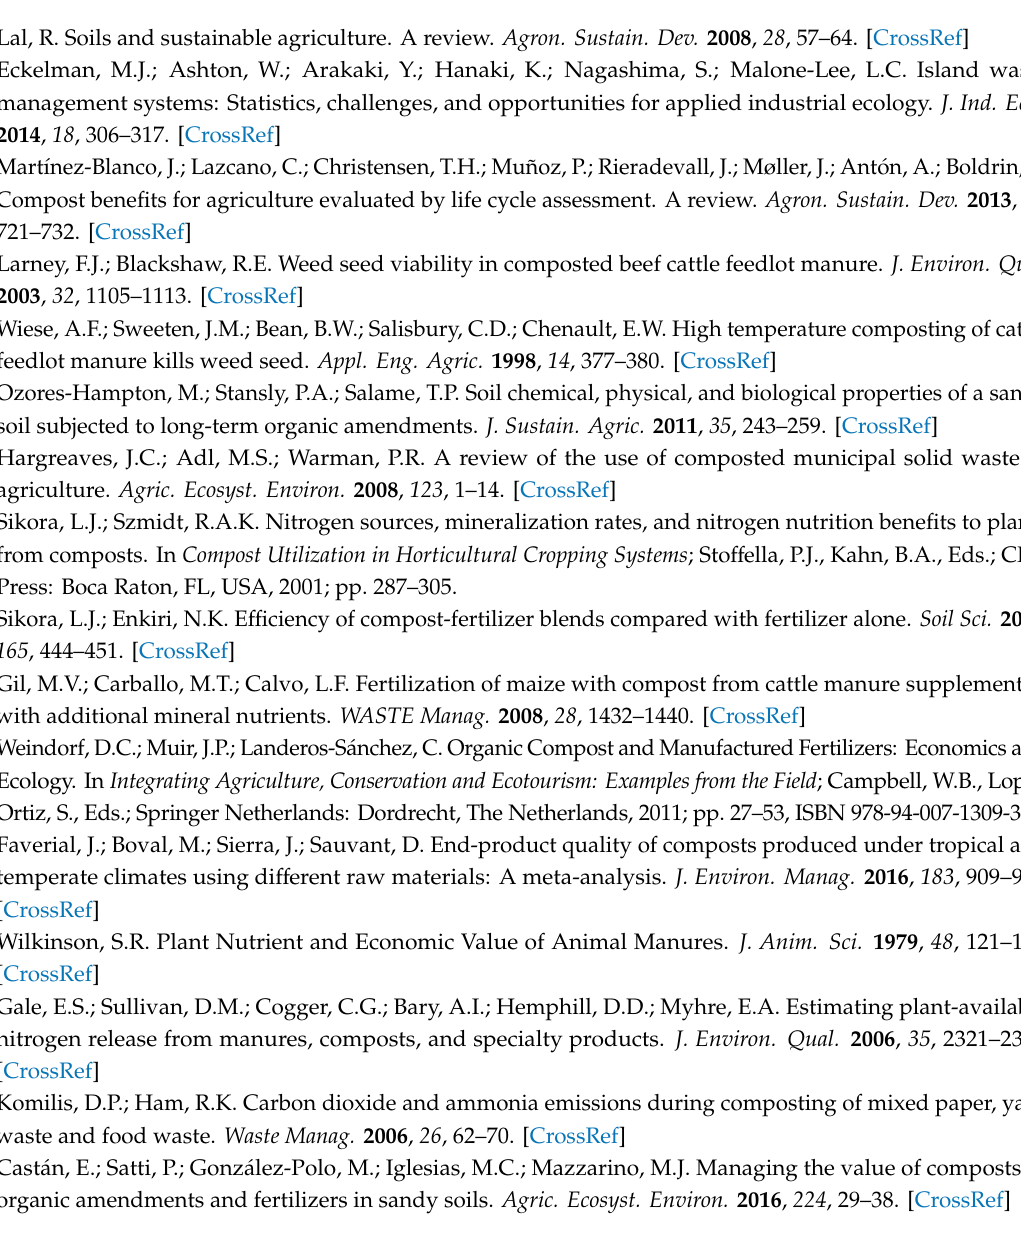
Table S1: Soil N-NH 4 + concentrations (mg N kg − 1 ) during the incubation study. Table S2: Soil pH during the incubation